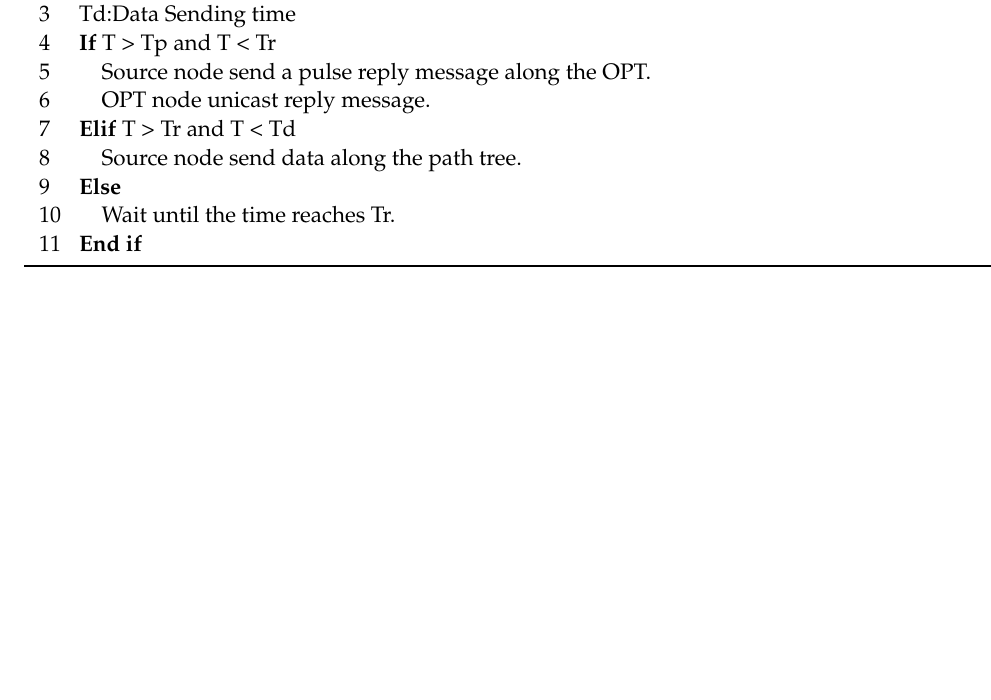
Algorithm 1. Source node path request process.